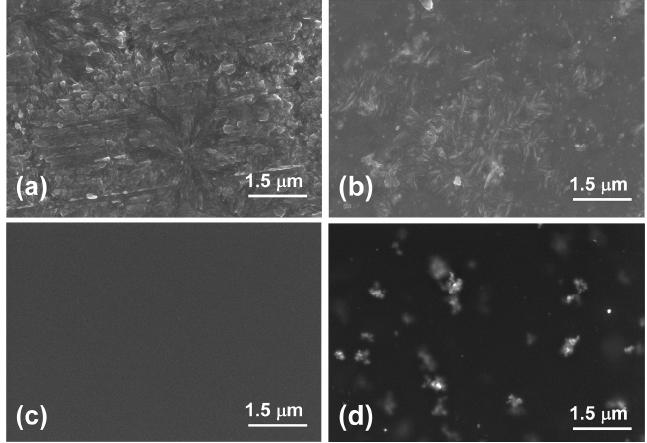
Figure 3. Scanning electron microscopy (SEM) images of the surface of ( a ) TPEQ-ODPA; ( b ) TPEQ-ODPA-S; ( c ) PMDA-ODA; and ( d ) PMDA-ODA-S.